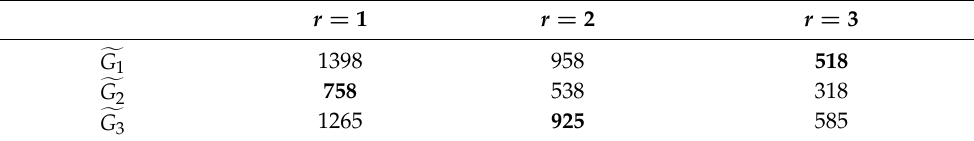
Table 5. Values χ ir of the linear problem (bold numbers are the optimal